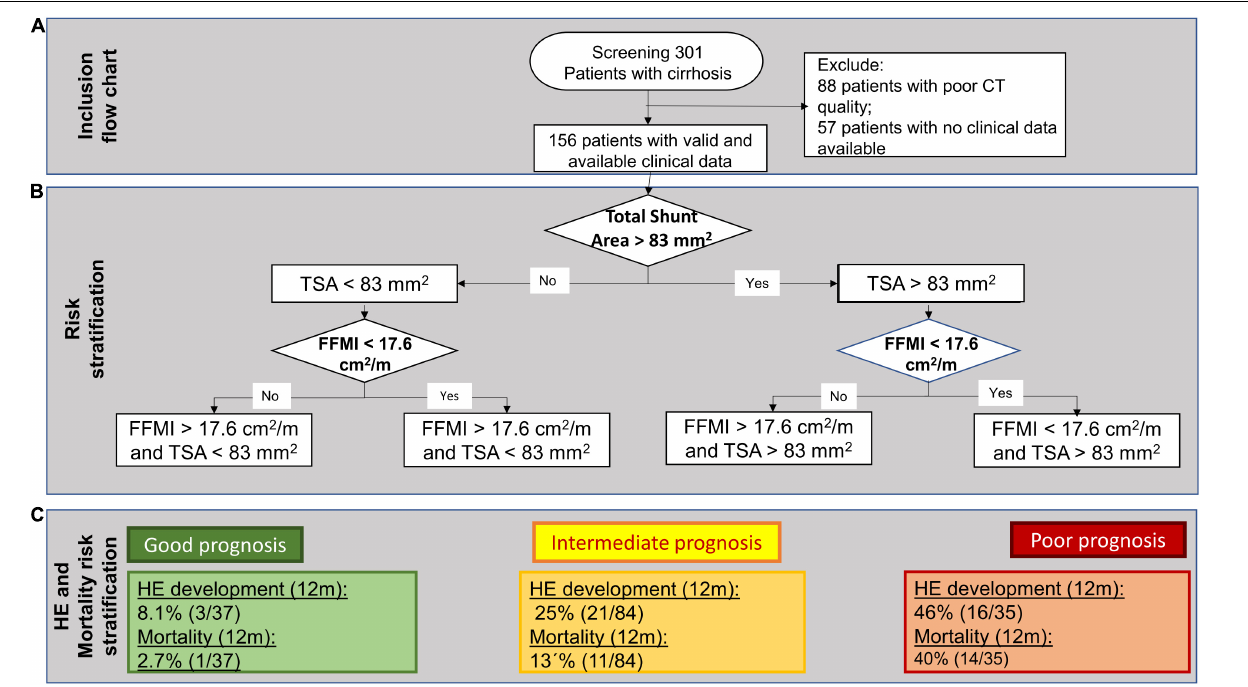
FIGURE 1 | (A) A flowchart of patient inclusion. (B) A decision tree algorithm for hepatic encephalopathy (HE) development and mortality, sequentially, including total spontaneous portosystemic shunt (SPSS) Area (TSA) and Fat-Free Muscle Index (FFMI). (C) Prognostic groups and their respective rates of 1-year HE development and 1-year